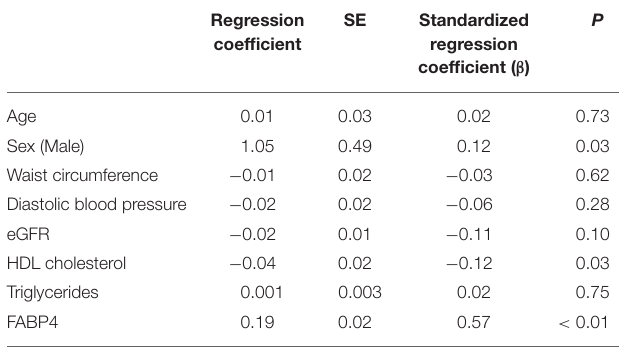
TABLE 5 | Multivariable regression analysis for